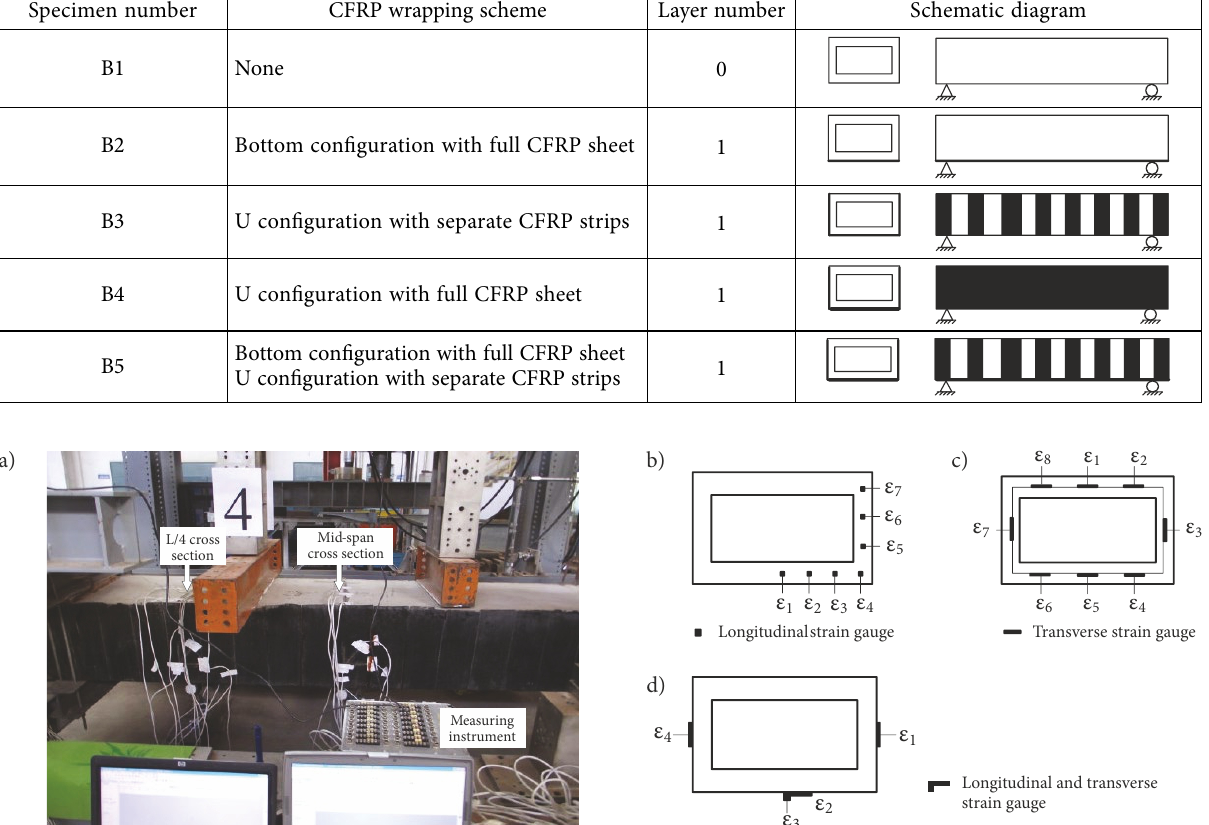
Figure 2. The testing arrangement and layout of strain gauge on the cross sections: a – experimental box-girder and measuring instrument; b – strain measurement of longitudinal reinforcements on the mid-span cross section; c – strain measurement of stirrup on the L/4 cross section; d – strain measurement of CFRP on the L/4 cross section